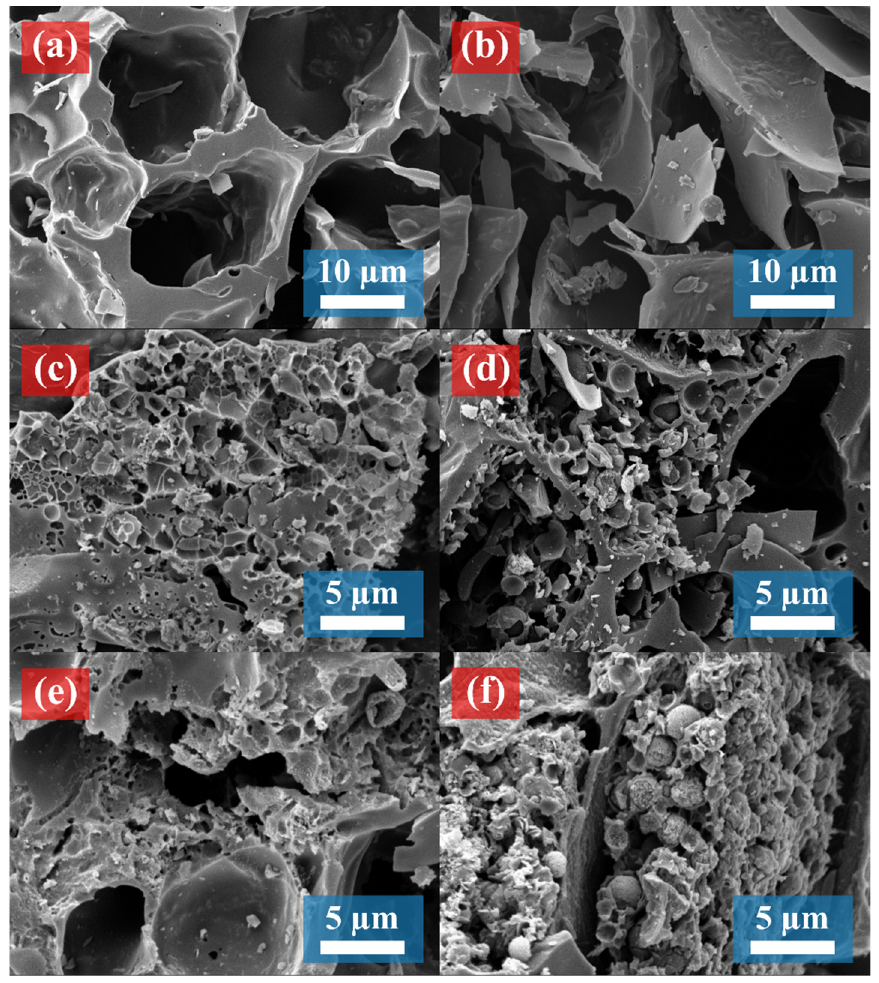
Figure 2. SEM images of ( a , b ) non-activated PC and ( c – f ) PAC samples with different activating agents of ( c ) KOH, ( d ) ZnCl 2 , ( e ) FeCl 3 , and ( f ) Mg.